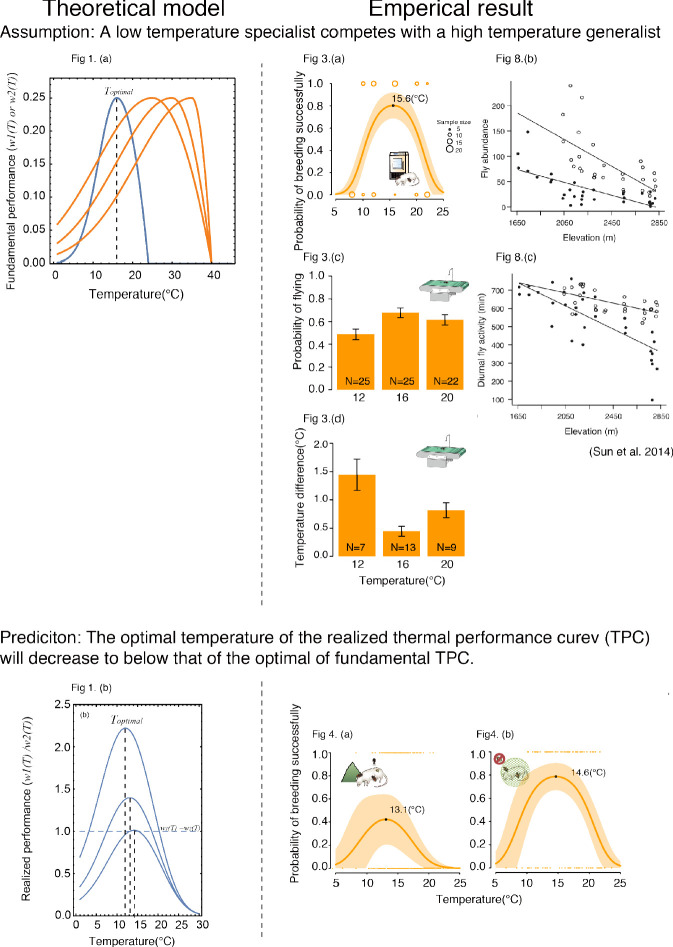
A summary of the theoretical and empirical data.